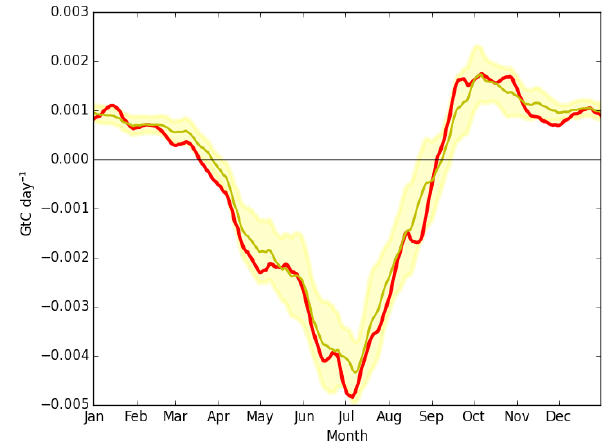
Figure 4. Time series of 10-day mean NEE budget (GtCday − 1 ) as- sociated with the crop vegetation type in North America from the MACC-13R1 optimized flux data set in 2010 (red line) compared to its climatology (2004–2013) (yellow line). The yellow shading represents the standard deviation of the optimized flux budget (for the same period) used to compute the inter-annual variability adjust- ment applied to the reference climatology. Positive/negative values correspond to a source/sink of CO 2